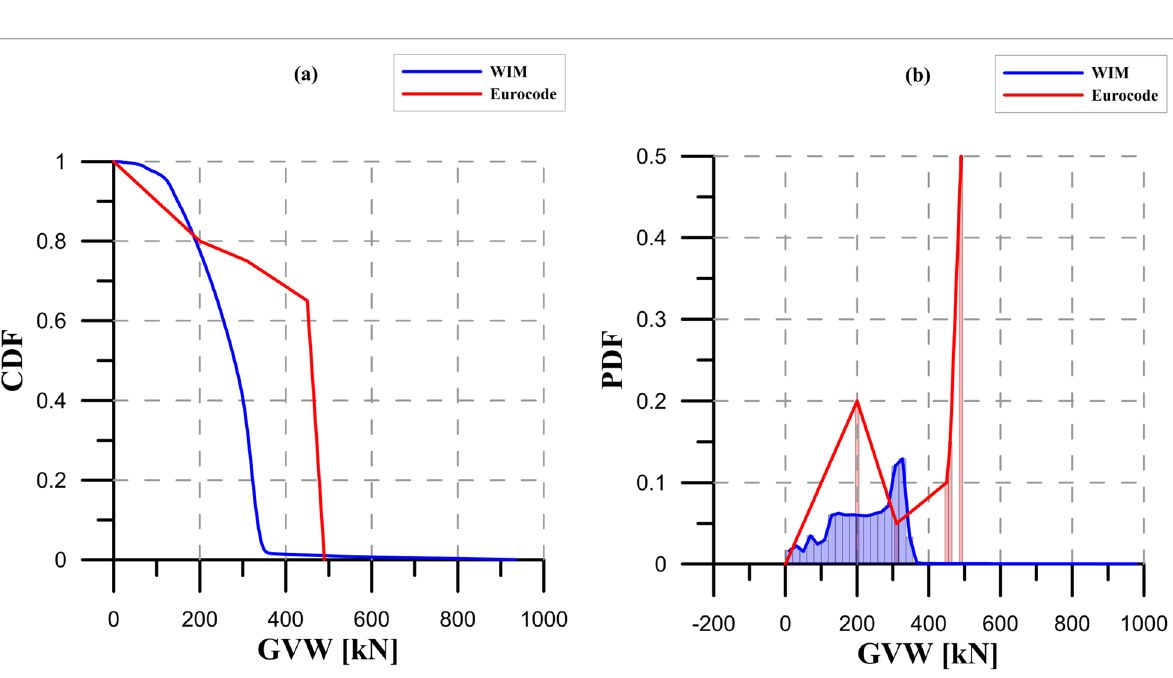
Fig. 3 Traffic hazard curve obtained from WIM system ( a ) and from Eurocode 1 ( b